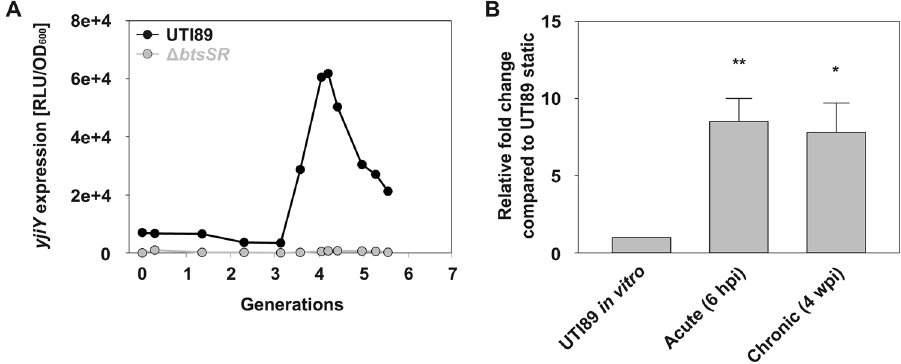
Figure 6. BtsS/BtsR importance during urinary tract infection. ( A ) The plot indicates the activity of the pBBR yjiY - lux reporter fusion in WT UTI89 and the isogenic btsS / btsR mutant during growth in LB, and depicts a representative of at least 6 biological replicates. ( B ) Change in the level of the yjiY transcript during acute and chronic phases of UTI relative to that measured in samples incubated in vitro without agitation. Data shown are the mean values of samples extracted from three different mice per time point. RNA was extracted from dissected bladders for each time point and enriched for bacterial RNA by depleting ribosomal and mammalian RNA as described in Materials and Methods. Profiling was performed using an yjiY -specific probe. Expression was normalized to that of the housekeeping gene gyrB and compared to expression in cDNA samples corresponding to the starting inoculum (static in vitro culture, prepared as described in Materials and methods). Relative fold change was measured using the method described by Pfaffl et al . 54 (hpi, hours post infection; wpi, weeks post